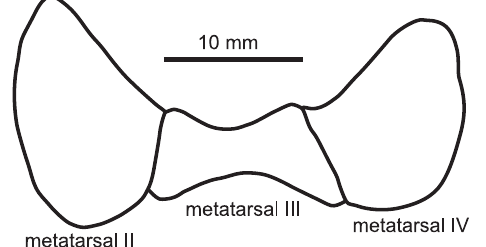
Fig. 2. Cross section demonstrating the deep plantar concavity of the tarsometatarsus of elmisaurine dinosaur Leptorhynchos elegans (Parks, 1933) (ROM 781) from the Upper Campanian Dinosaur Park Formation, Dinosaur Provincial Park, Alberta,